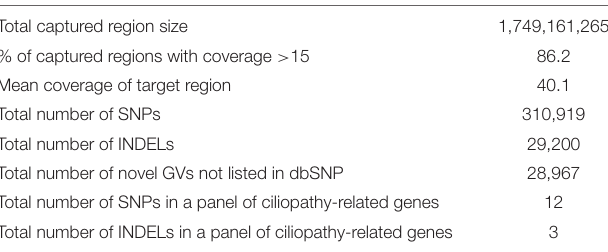
TABLE 1 | Summary of whole exome sequencing on the